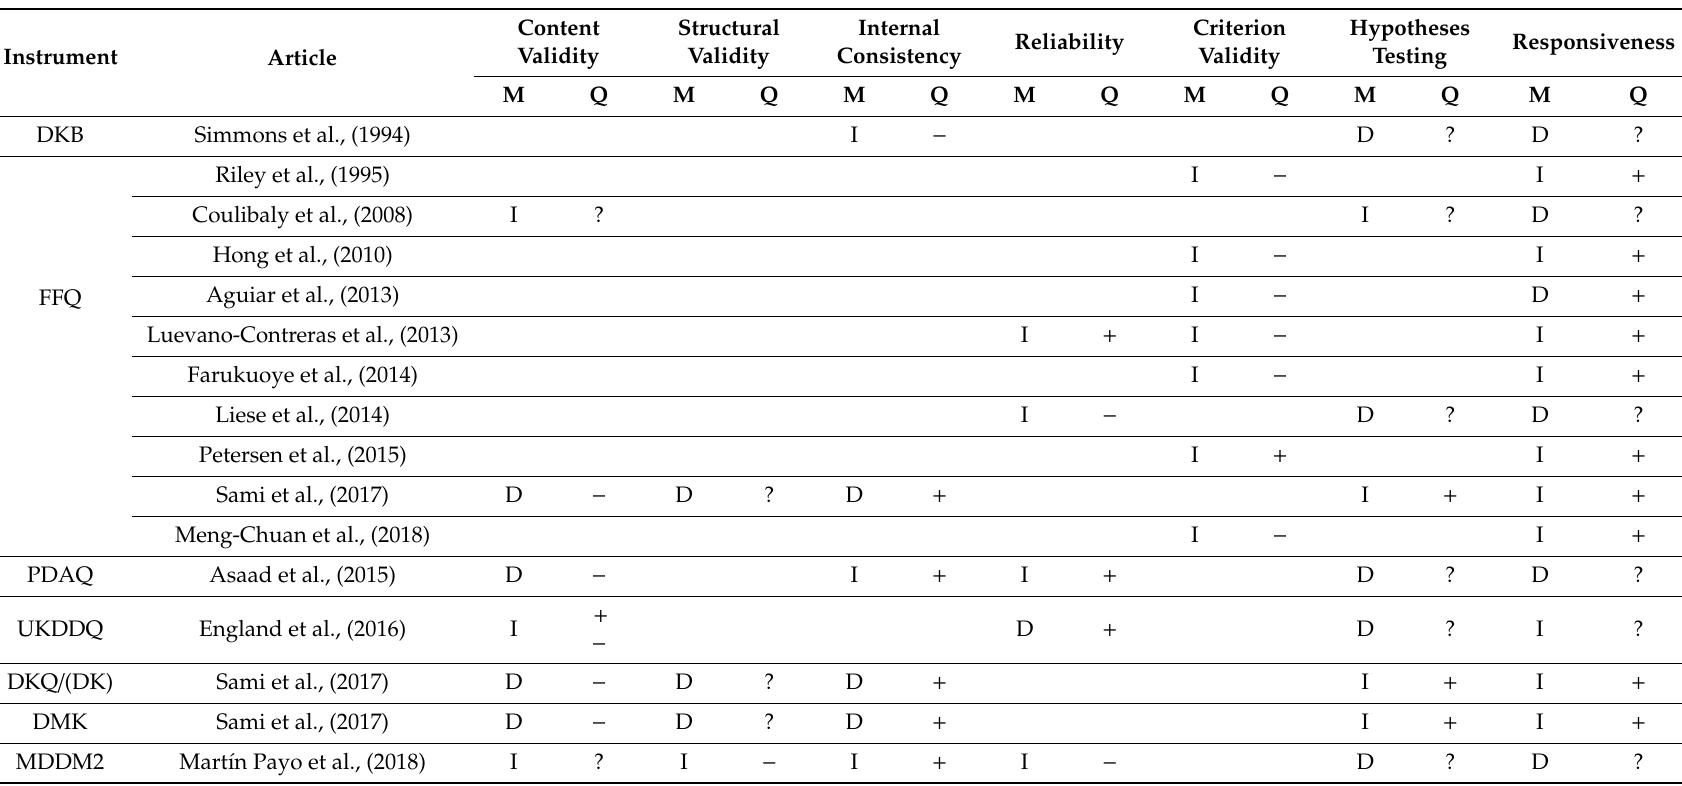
The cross-cultural validity / measurement invariance and measurement error were omitted in the table because they were not evaluated in any studies. M: Methodological quality of the study rated as I = Inadequate, D = Doubtful; empty boxes = not reported. Q: Quality of the results rated as + = positive rating, ? = indeterminate rating, ± = inconsistent rating, − = negative rating; empty boxes = not